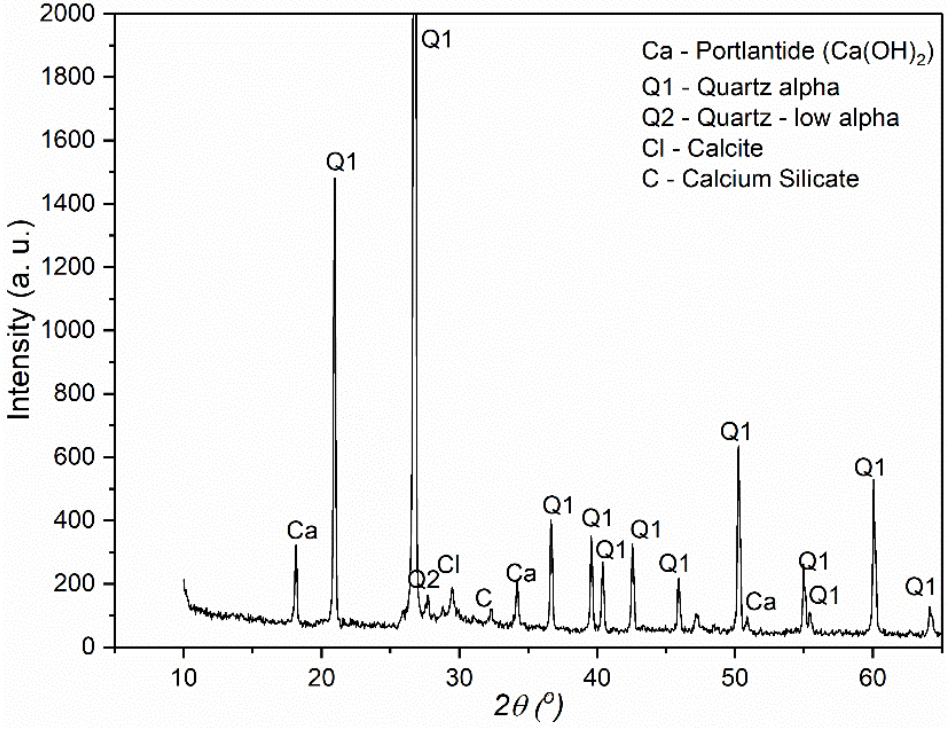
Figure 7. XRD analysis of the hardened mortar sample P20-M.